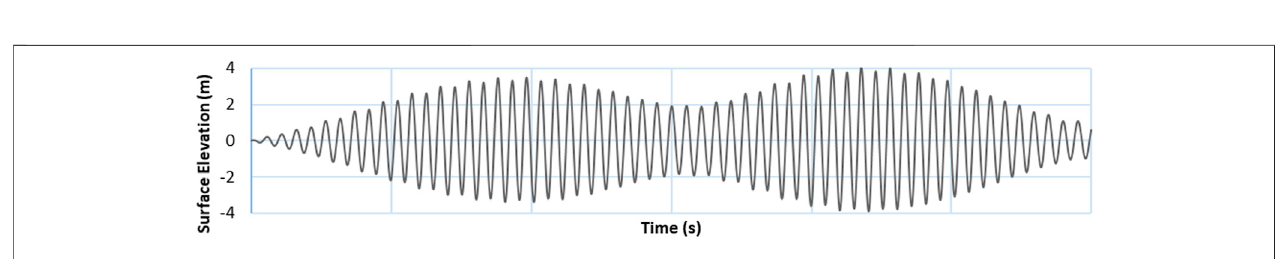
FIGURE 7 | Surface elevation pro fi le of alderney race with the friction coef fi cient of 0.005.